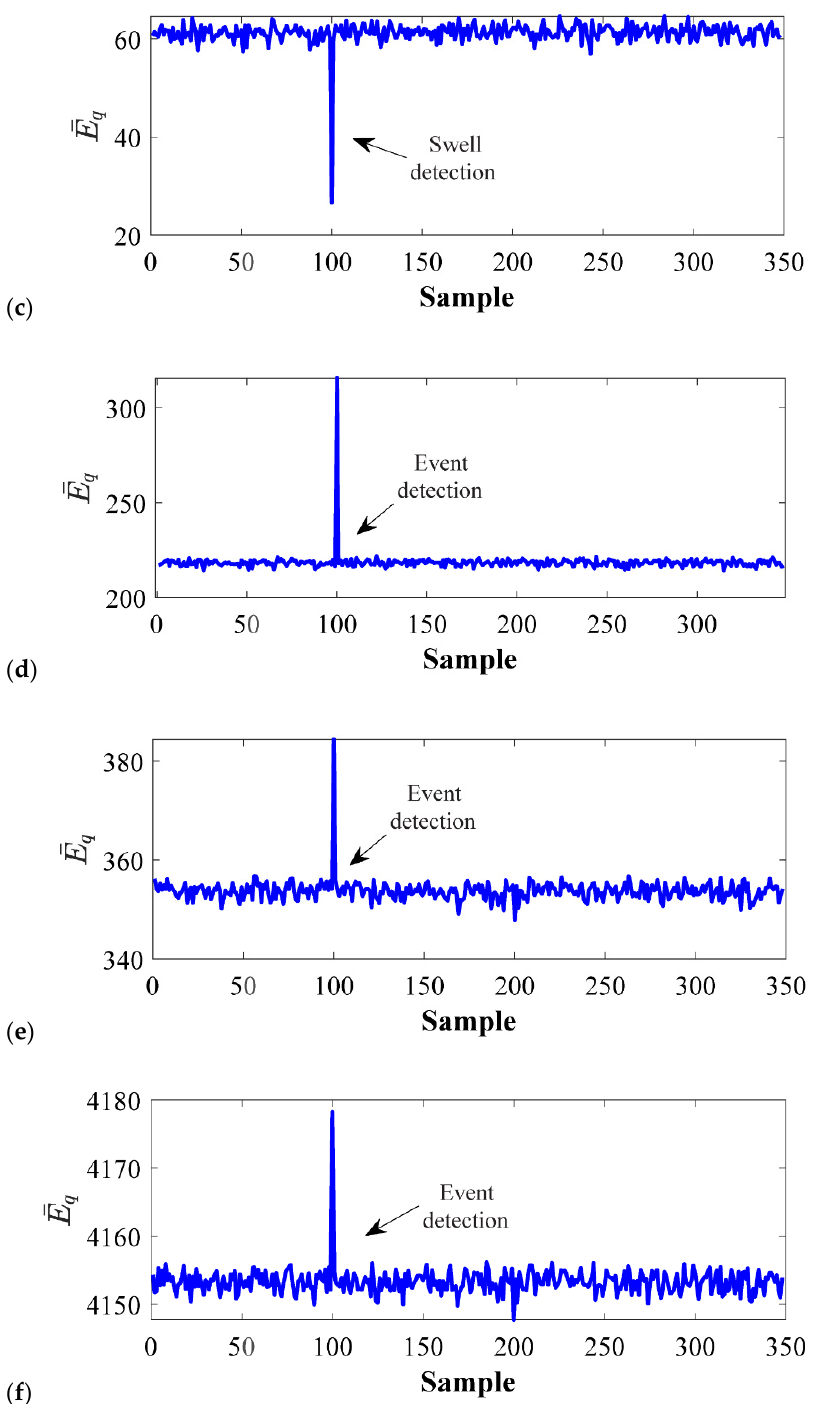
Figure 10. Achieved quantization error, E q , during the assessment of a real signal over the SOM neuron grids that models the conditions of: ( a ) normal condition, ( b ) sag, ( c ) swell, ( d ) fluctuation, ( e ) harmonic and ( f ) transients.